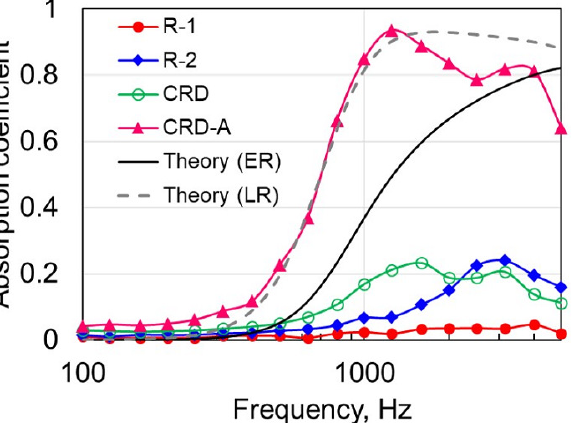
Figure 6. Measured absorption coefficients of R-1, R-2, CRD and CRD-A compared with the theoreti- cal absorption coefficients of a single permeable membrane absorber based on an assumption of an extended reaction (ER) and a local reaction